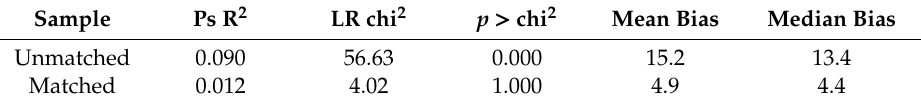
Table 4. Balancing test of observable variables in propensity score matching (PSM).